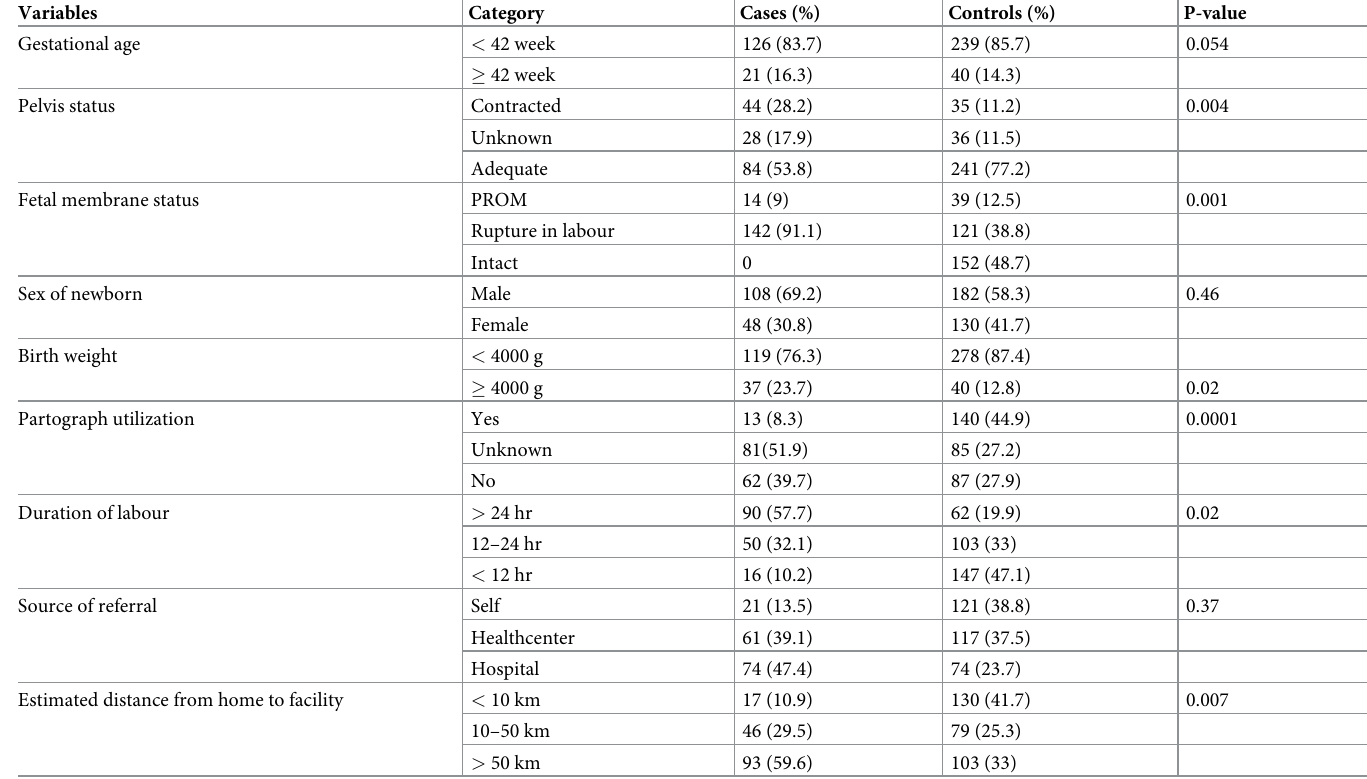
Table 2. Intrapartum and health facility factors of obstructed labour among women who gave birth in HUCSH from 2015–2017. Intrapartum, and health facility characteristics of obstructed labour in HUCSH,